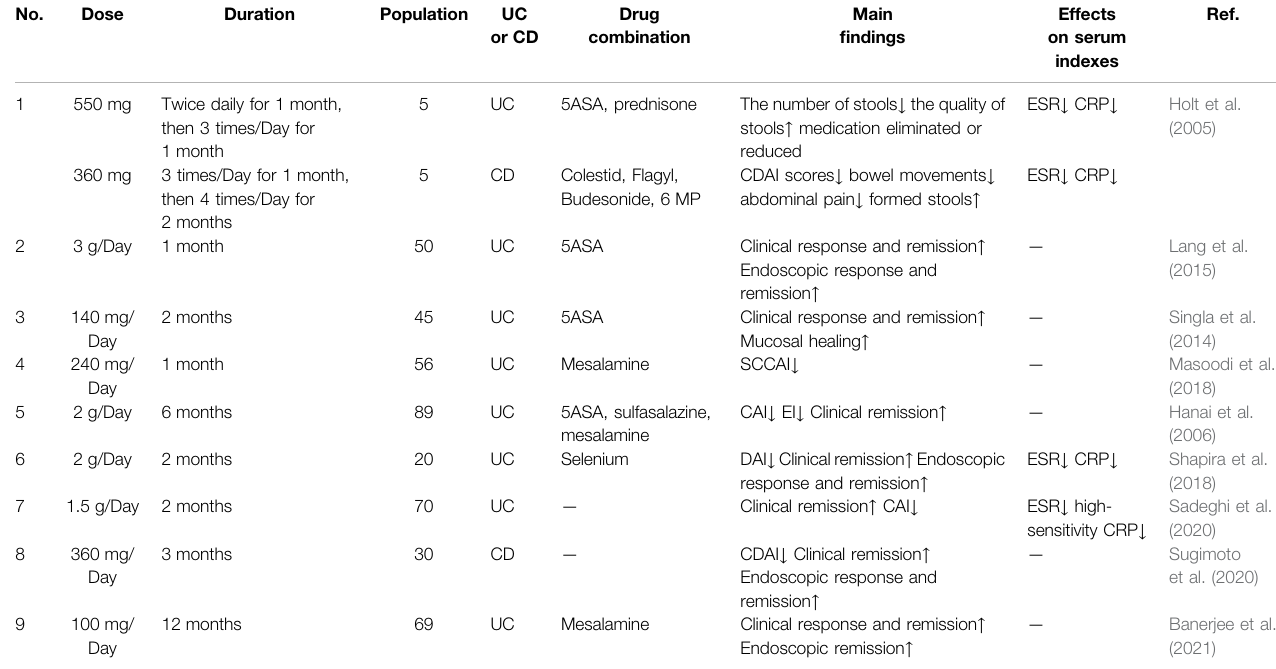
TABLE 4 | Details of curcumin ’ s role in in fl ammatory bowel disease treatment in clinical trails.